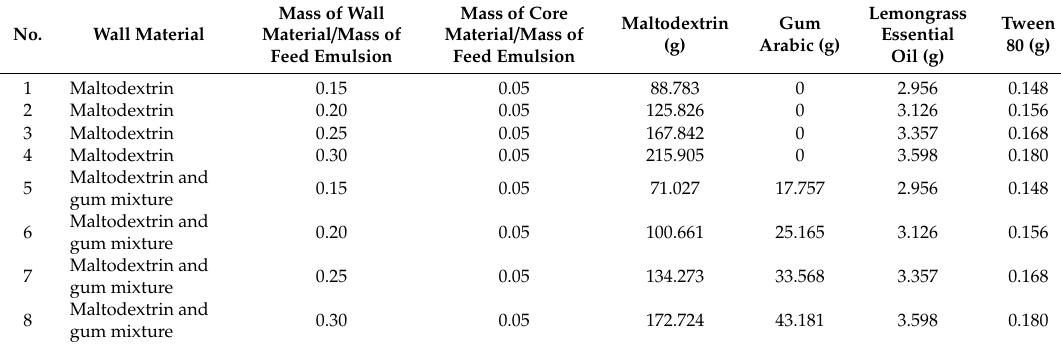
Table 1. Feed emulsion compositions in the first investigation.